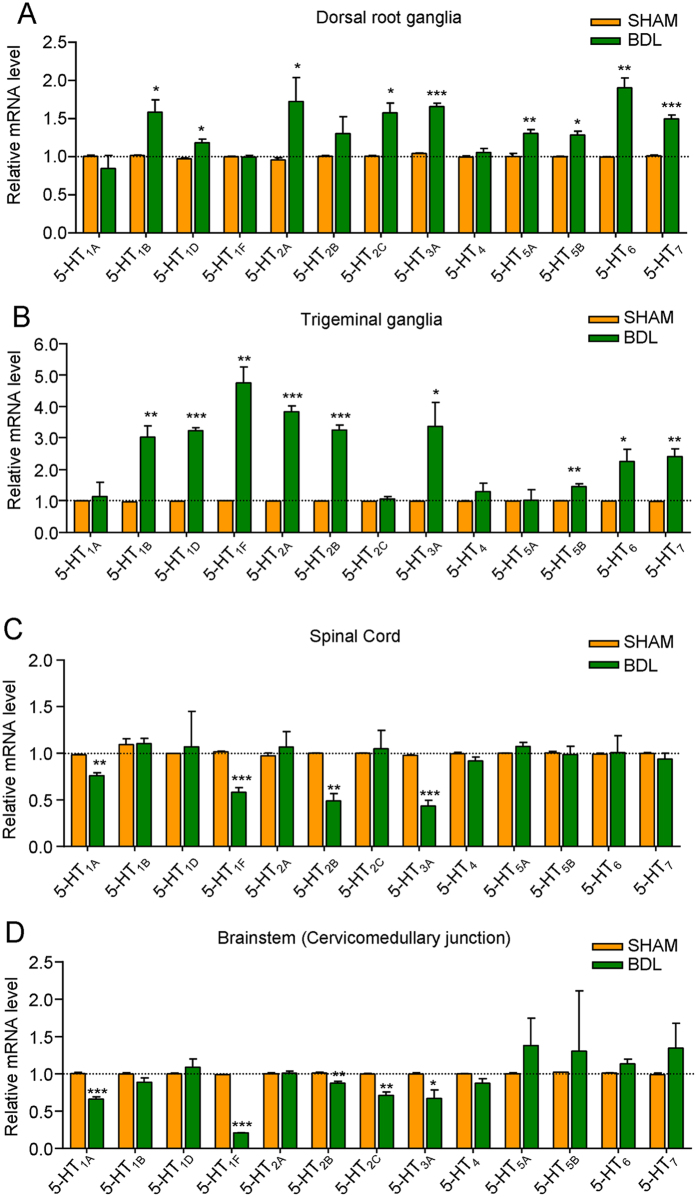
Q-PCR analysis revealed the expression profile of 5-HT receptor subtypes in peripheral and central nervous system (CNS) in sham and BDL rats.Real-time quantitative PCR (qPCR) analysis showed that mRNA expression changes of different 5-HT receptors subtypes in dorsal root ganglia (A), trigeminal ganglia (B), spinal cord (C), and brainstem (D). Notably, multiple 5-HT receptors were up-regulated in dorsal root ganglia or trigeminal ganglia from BDL rats, including 5-HT1B, 5-HT1D, 5-HT1F, 5-HT2A, 5-HT2C, 5-HT3A, 5-HT5A, 5-HT5B, 5-HT6, and 5-HT7. In contrast, several 5-HT receptors were down-regulated in the spinal cord or brainstem from BDL rats, including 5-HT1A, 5-HT1F, 5-HT2B, 5-HT2C and 5-HT3A. (n = 6 per group) (*P < 0.05; **P < 0.01, ***P < 0.001 versus sham values and analyzed by Student’s t-test).